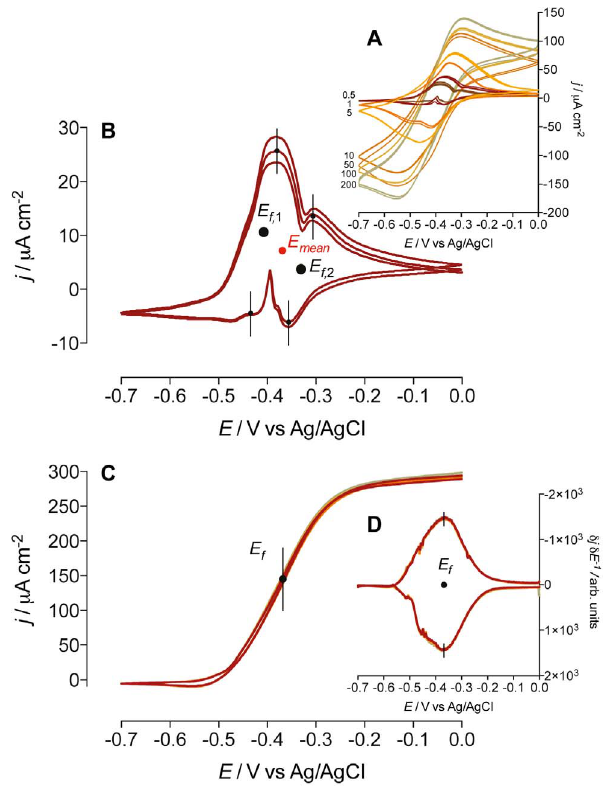
Figure 1. Cyclic voltammograms (CVs) obtained from the electroactive biofilms. A) Nonturnover CVs recorded in acetate- depleted medium at scan rates ranging from 0.5 to 200 mV s 2 1 (as indicated). B) Nonturnover CV recorded at the scan rate of 0.5 mV s 2 1 . The two redox couples E f,1 and E f,2 are centered at the formal potentials of 2 407 mV and 2 331 mV, respectively. E mean , centered at 2 369 mV, indicates the arithmetic average of E f,1 and E f,2 . C) CVs of an electroactive biofilm metabolizing acetate ( i.e. , turnover conditions), recorded at a scan rate of 0.5 mV s 2 1 . D) First derivatives of the turnover voltammetric curve performed at 0.5 mV s 2 1 . E f represents the putative electron-transfer site, centered at 2 368 mV.